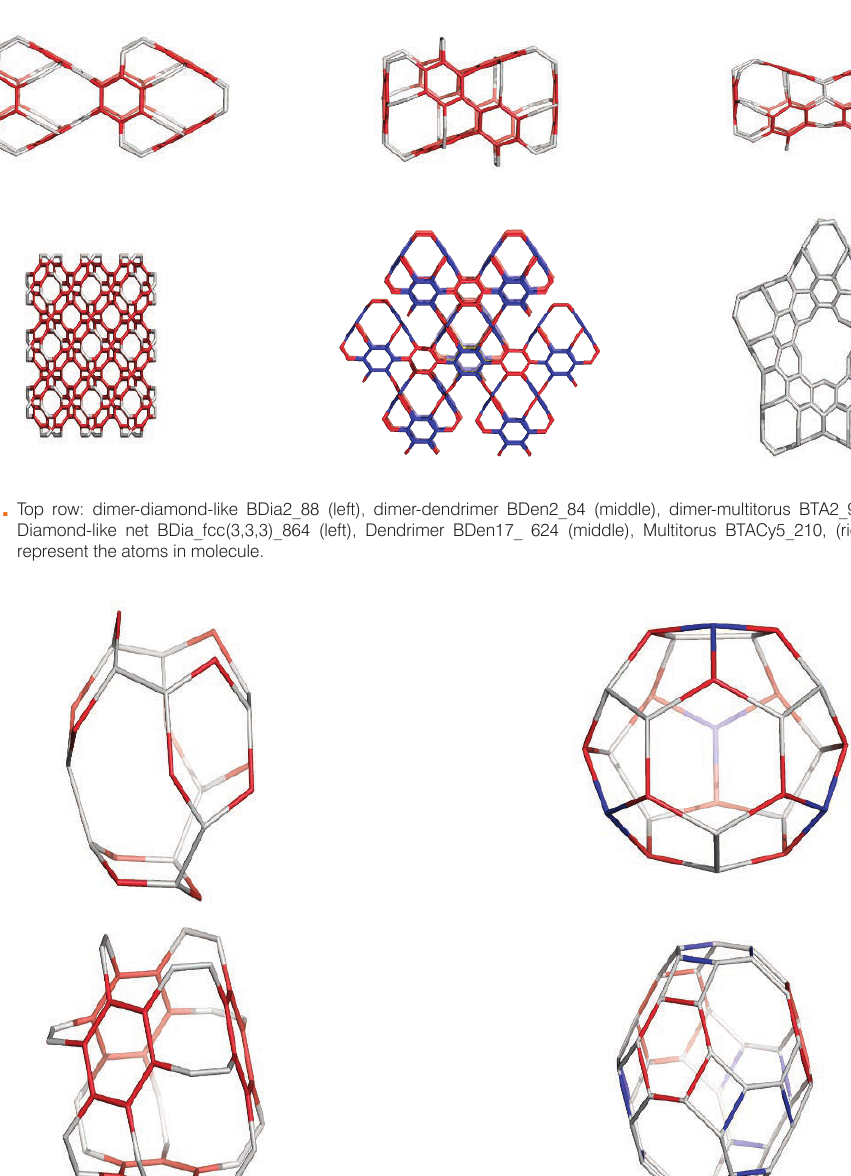
(T)_28 = C by deleting the four blue points located at the centre of pentagon triples. Bottom 2 28 (T))_48 cage following the blue bonds. 4